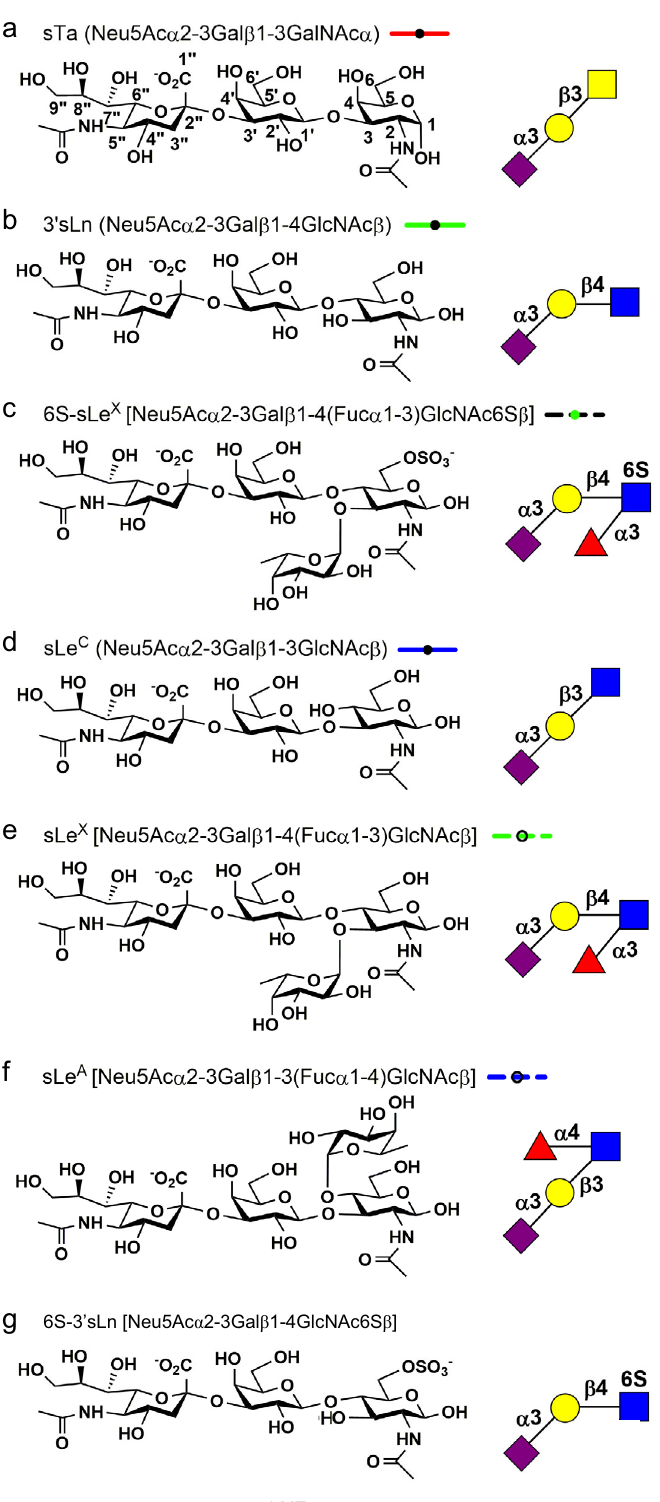
Fig. 1 Sialoglycans used in this study. a sialyl-T antigen, b sialyllactosamine, c 6S-sialyl Lewis X, d sialyl Lewis C , e sialyl Lewis X, f sialyl Lewis A, g 6S-sialyllactosamine. The chemical structure of each indicated sialoglycan is shown on the left with the symbolic representation shown on the right. The line style used for all dose response curves is shown to the right of each